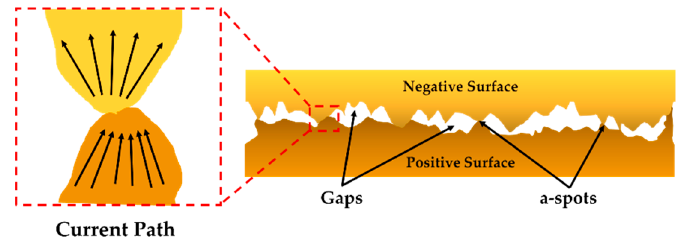
Figure 4. Contacting asperity peaks/ “a-spots” creating the conducting path for electrons.